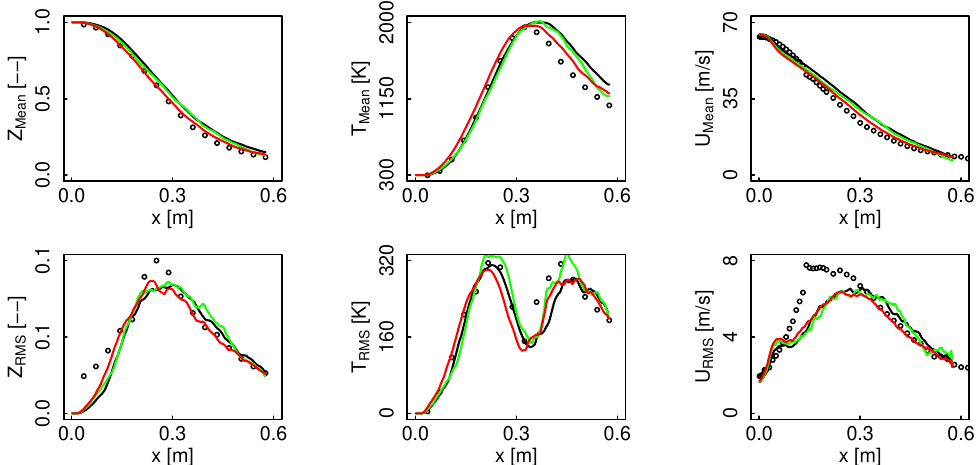
Figure 4. Flame D mixture fraction, temperature and velocity profiles along the centerline. Black color represents non-premixed FTACLES, green color premixed FTACLES, red color FPV, and circles depict the experimental